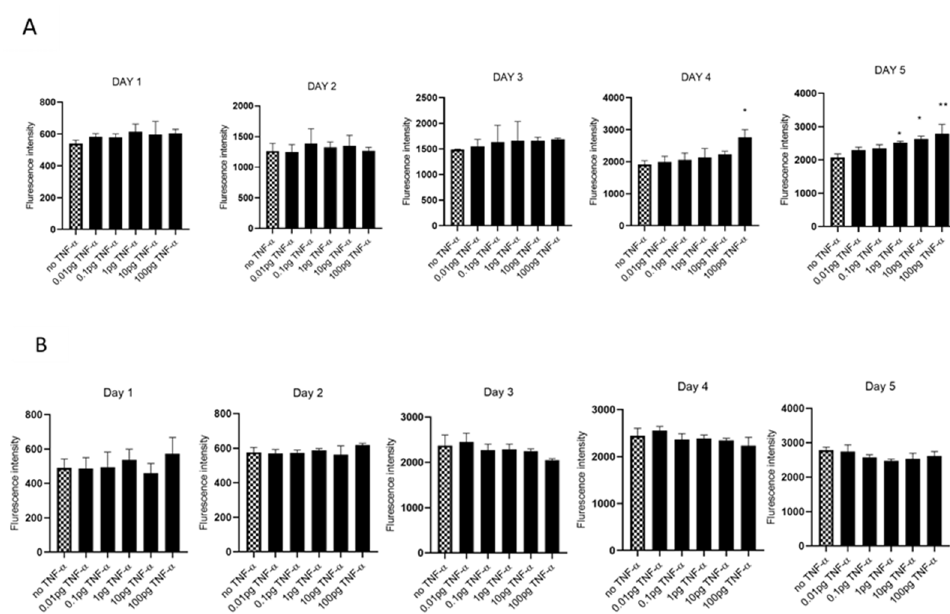
Figure 1. Cell proliferation in response to TNF- α treatment. ( A ) SW480 and ( B ) HCT116 cells were treated with doses of TNF- α (0.01–100 pg/mL) over 5 days. Cell proliferation was determined using alamarBlue assay. Data are expressed as fluorescence intensities compared to vehicle control (no TNF- α treatment). Significant difference was calculated using one-way ANOVA followed by Dunnett’s test (GraphPad Prism 8, ** p < 0.01, * p < 0.05). Error bars represent the SEM for six replicates and